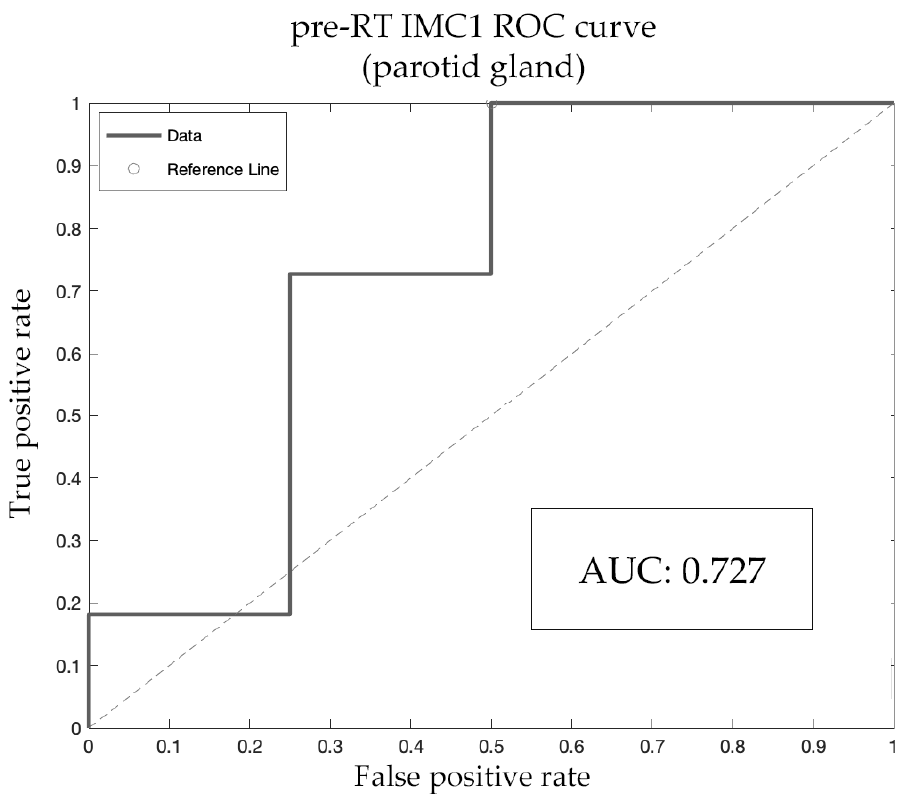
Figure 4. Receiver operating characteristics (ROC) curve for IMC 1 in the parotid gland (pre-RT population). Diagnostic accuracy was considered acceptable when the AUC values were higher than 0.7.